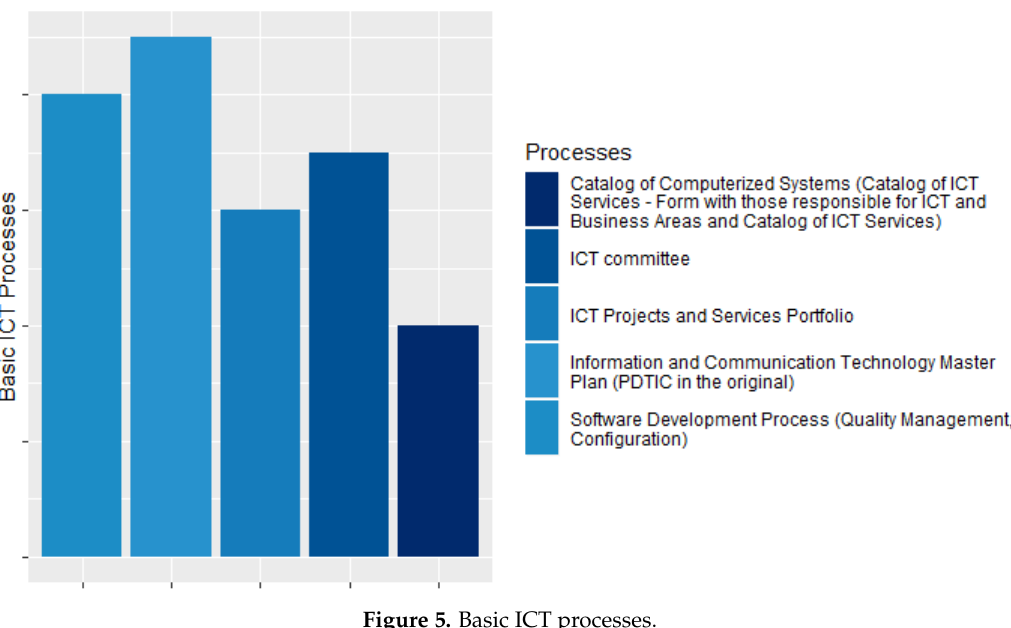
Figure 5. Basic ICT